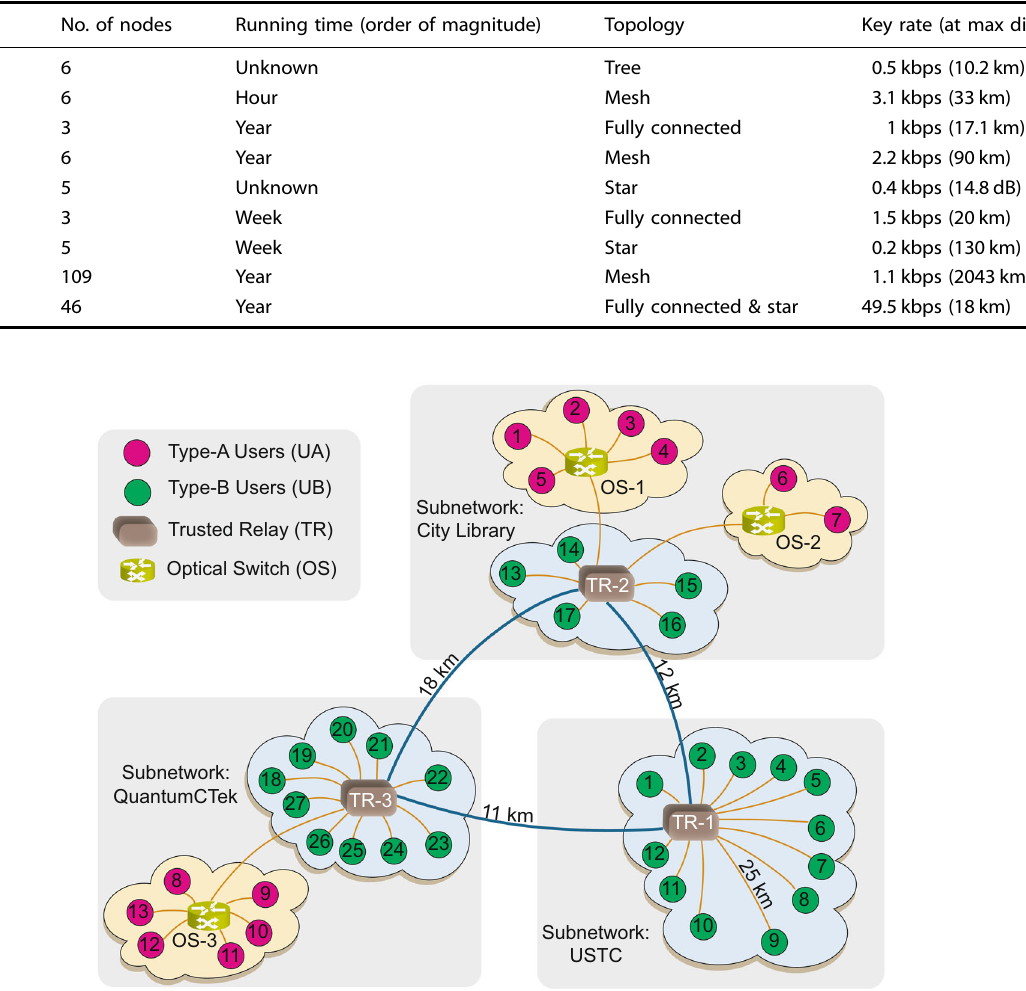
Fig. 1 The topological structure of our quantum network. The network mainly comprises three subnetworks that are directly connected to each other. In each subnetwork, there are multiple users connected to intermediate nodes in different ways, either by an all-pass optical switch (OS) or by a trusted relay (TR). Users connected by a switch are denoted as red dots (Type-A Users, UA), holding both a quantum transmitter and a receiver. Users connected to a trusted relay are denoted as green dots (Type-B Users, UB), only holding a quantum transmitter. Speci fi cally, UA-1 to UA-5 are connected to OS-1, UA-6 and UA-7 are connected to OS-2, UA-8 to UA-13 are connected to OS-3, UB- 1 to UB-12 are connected to TR-1, UB-13 to UB-17 are connected to TR-2, and UB-18 to UB-27 are connected to